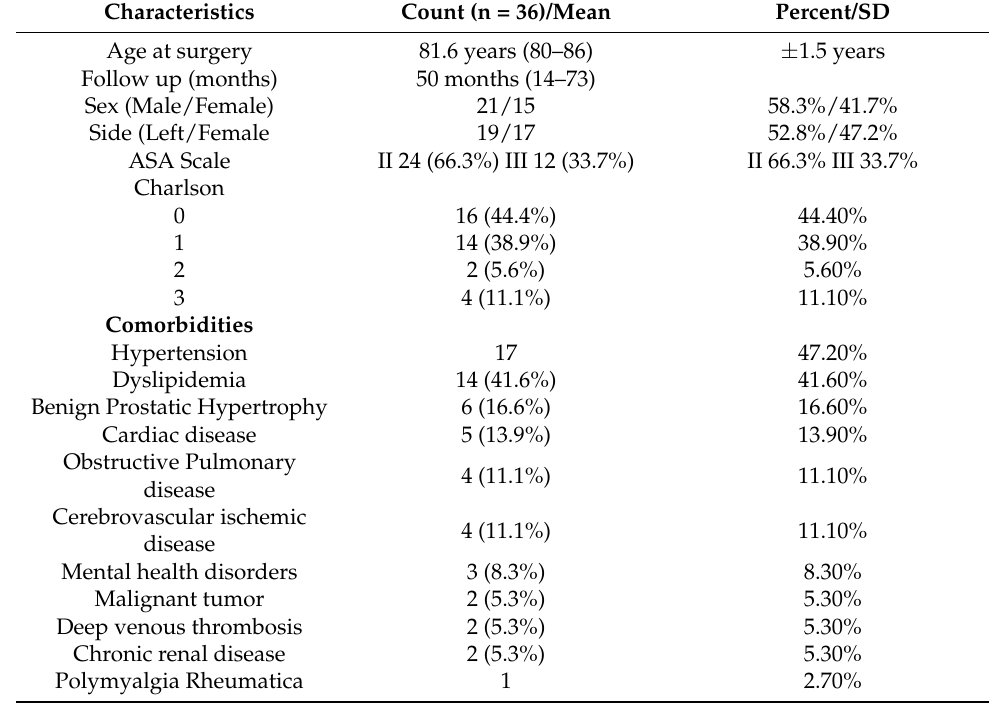
Table 1. Patients Demographics and Preoperative Medical